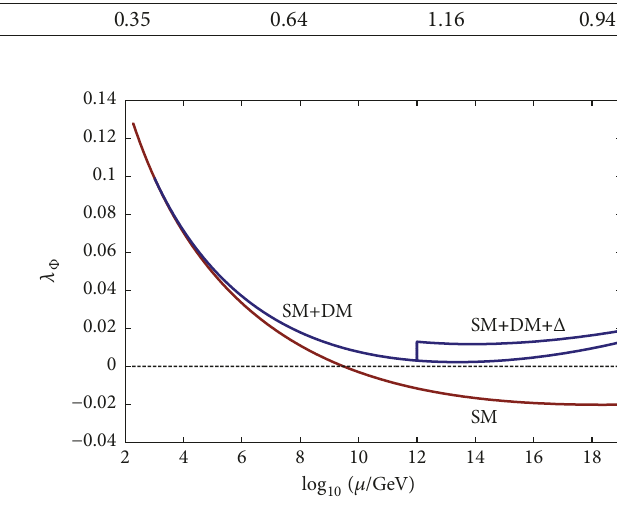
Figure 9: Running of standard Higgs quartic coupling including heavy triplet scalar threshold effect at 𝜇 = 𝑀 Δ = 10 12 GeV derived from fits to neutrino oscillation data. The curves labeled as SM, SM+DM, and SM+DM +Δ denote contributions due to SM alone, SM plus DM, and SM plus DM plus Higgs triplet threshold effect, respectively, as described in the text. The scalar DM mass has been fixed at 𝑀 DM = 1.0 TeV consistent with LUX:2016 experimental